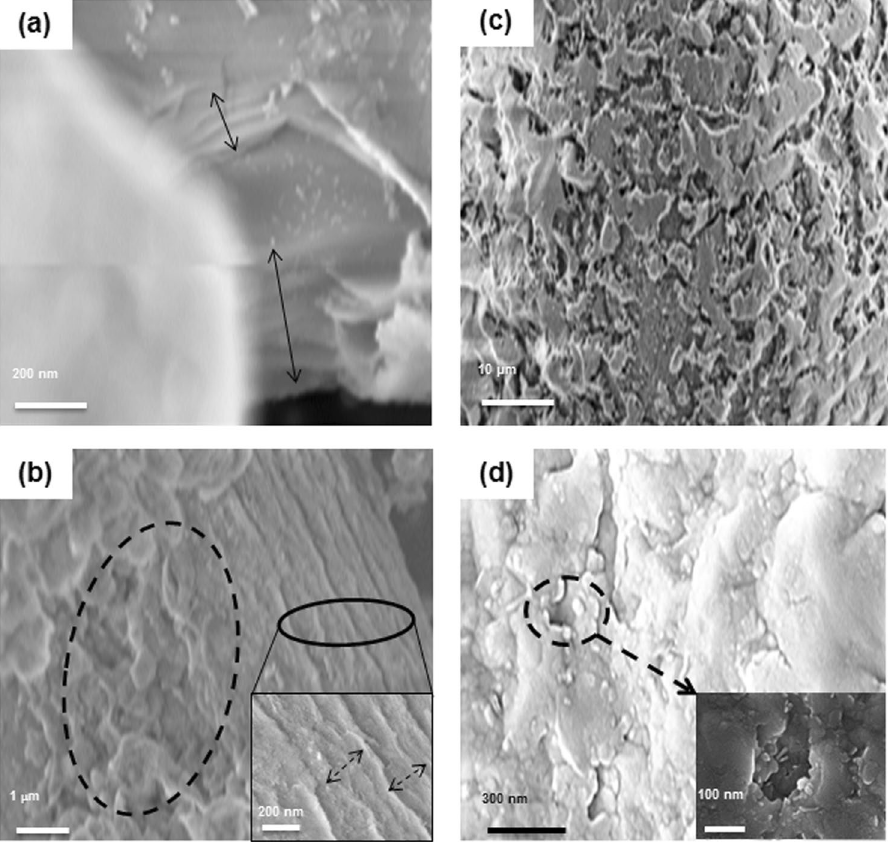
Figure 2. SEM images of ( a ) unmodified MK10; arrows indicate layer structures, ( b ) MK10_PEI_Cu NPs; dotted ellipse show small exfoliation and insert show higher magnification and arrows indicating slight expansion of the layer structure to ~2 Ǻ ( c ) sand, and ( d ) sand_PEI-Cu NPs; dotted ellipses and insert show higher magnification and deposited PEI_Cu